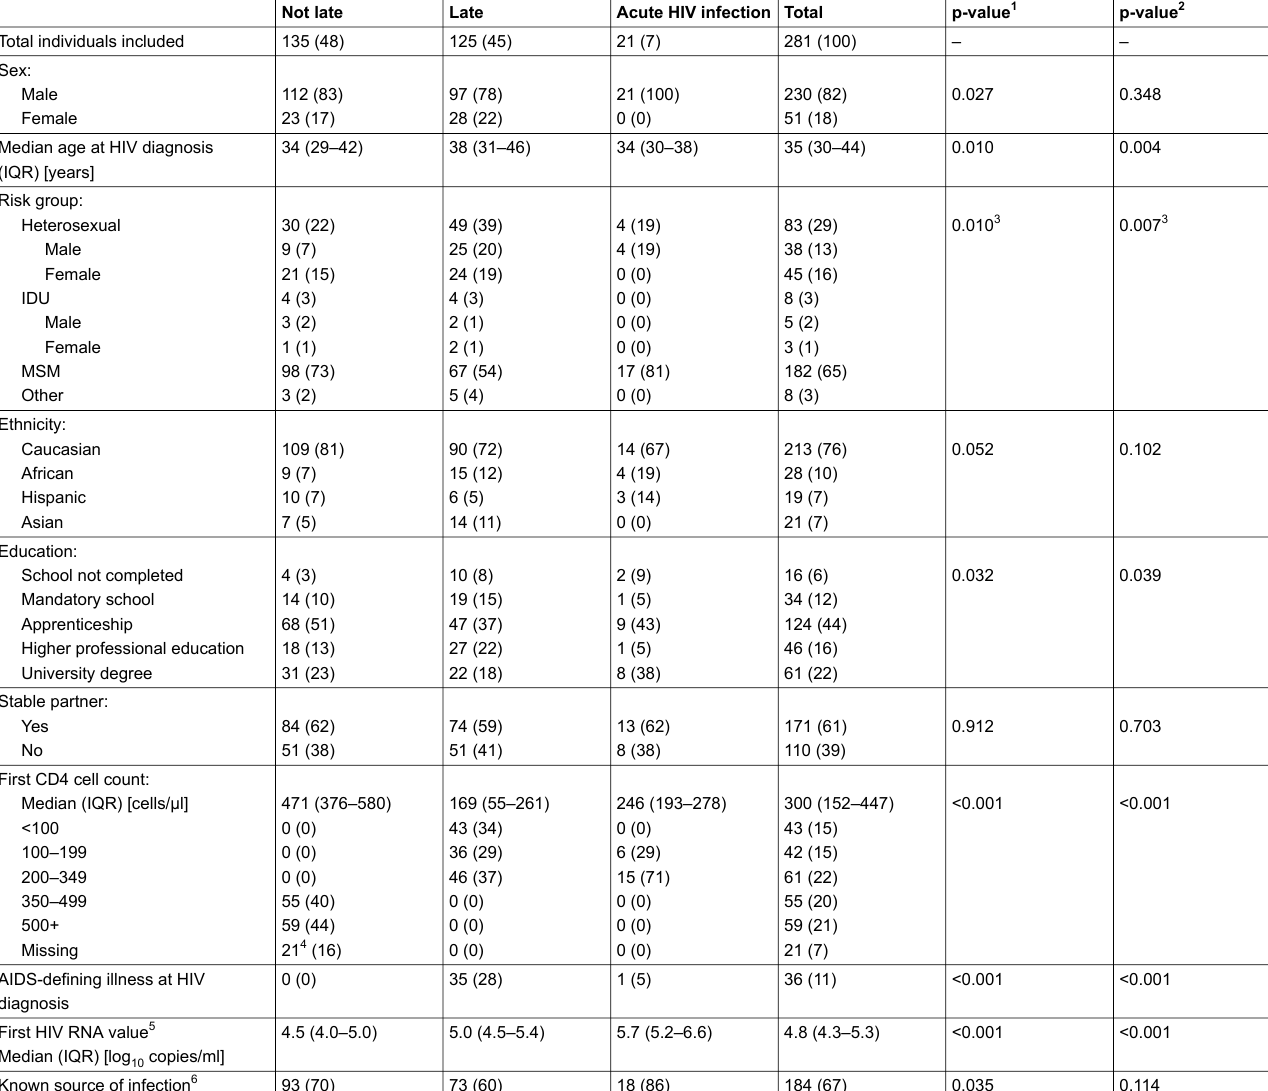
Table 1: Characteristics of the 281 individuals enrolled at the Zurich centre of the Swiss HIV Cohort Study between 01 January 2009 and 07 December 2011 and included in this analysis. Late presenters (n = 125) and people with acute HIV infection (n = 21) had CD4 cell counts below 350 cells/µ or AIDS at enrollment. The remaining 135 persons represent the comparison